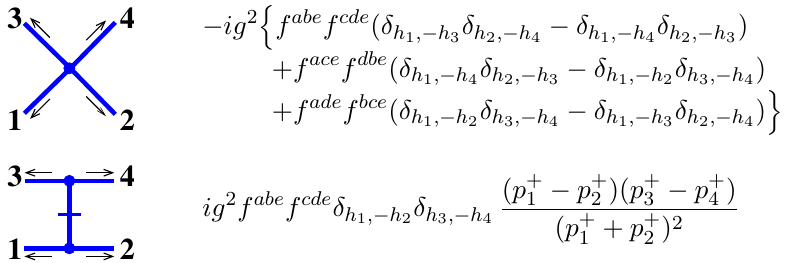
Figure 12 . Ordinary Feynman rule results in lightcone gauge for the four-gluon interactions appearing in our “ F ” diagrams. By ordinary Feynman rules, we mean that (i) there is no direction of time in the above diagrams, (ii) we are not yet taking the large- N c limit nor yet separating out different large- N c color routings, and (iii) we are only talking about the interaction in an amplitude and are not thinking here about the conjugate amplitude. As in the rest of the text, unbarred lines refer to transversely polarized gluons, and the barred line is a longitudinally polarized gluon. ( a, b, c, d ) are the adjoint-index colors of gluons (1 , 2 , 3 , 4) respectively, and ( h 1 , h 2 , h 3 , h 4 ) are the corresponding helicities ± flowing in the direction of the arrows. The Kronecker deltas arise from dot products (cid:15) i · (cid:15) j = δ h of the two-dimensional unit polarization vectors of i , − h j